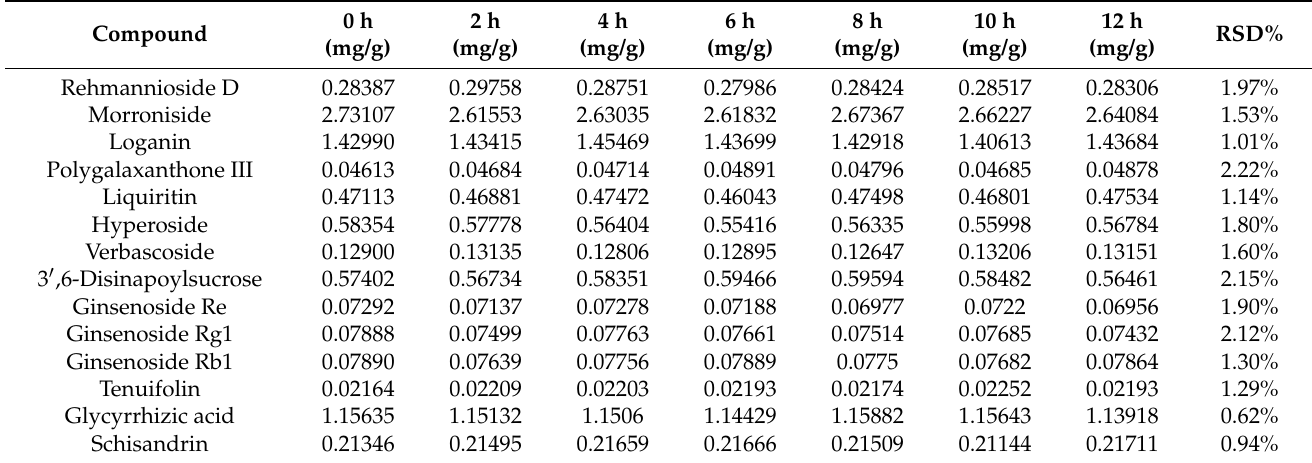
Table 6. Stability study results of 14 analytes.